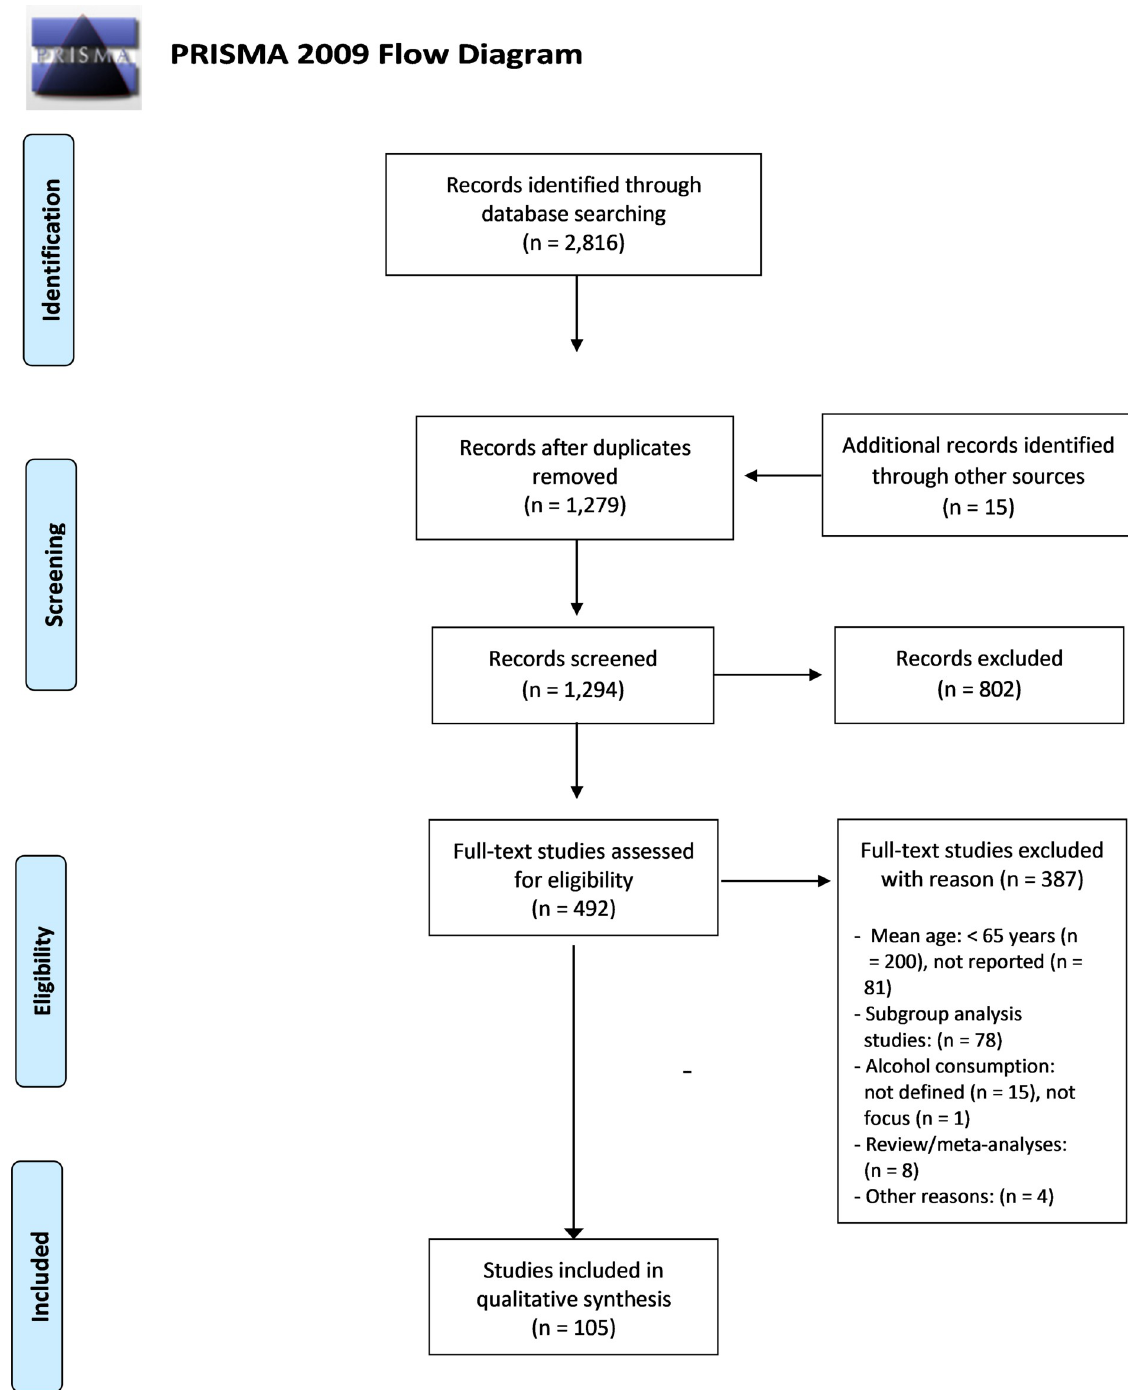
Fig 1. Flow diagram depicting study identified, screened, assessed for eligibility, and included in this review [51].